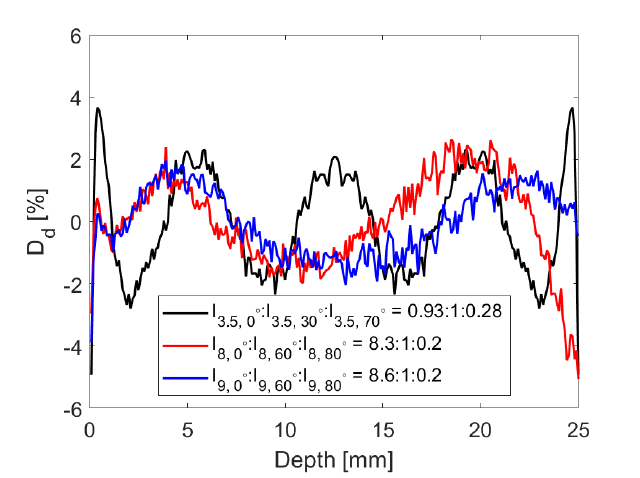
Figure 16. Comparison of dose deviation of single- and double-sided irradiation. I is the intensity as given in Equation